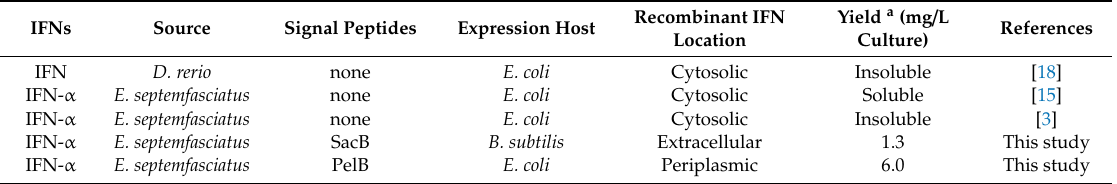
Table 1. Overexpression of recombinant fish IFNs in heterologous